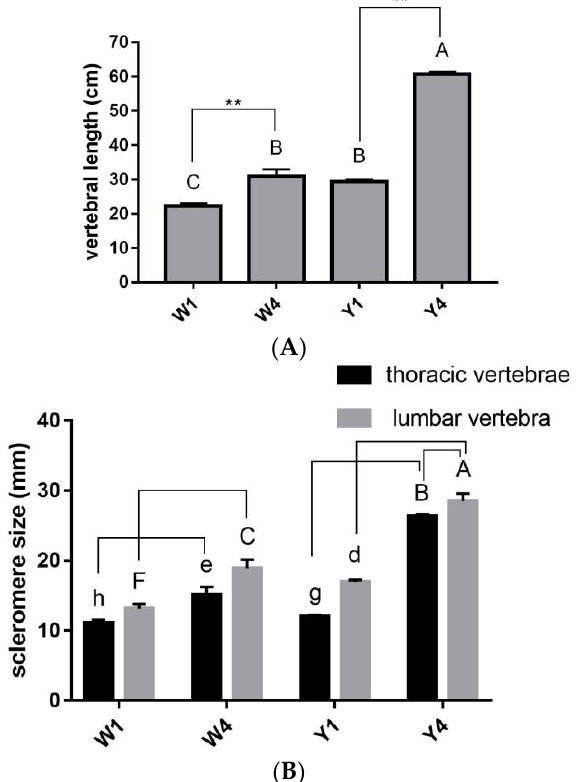
Figure 1. The vertebral development in pigs. Shorter vertebral ( A ), thoracic vertebral, and lumbar vertebral scleromeres ( B ) were detected in the 1-month-old Yorkshire and Wuzhishan pigs than in the 4-month-old pigs. Results are shown as means ± SDs of triplicate measurements. Different letters indicate significant differences (d, e, g, h indicate p < 0.05; A, B, C, F indicate p < 0.01); the same letters indicate no significant difference. Y1, 1-month-old Yorkshire pigs; Y4, 4-month-old Yorkshire pigs; W1, 1-month-old Wuzhishan pigs; W4, 1-month-old Wuzhishan pigs. ** p < 0.01.